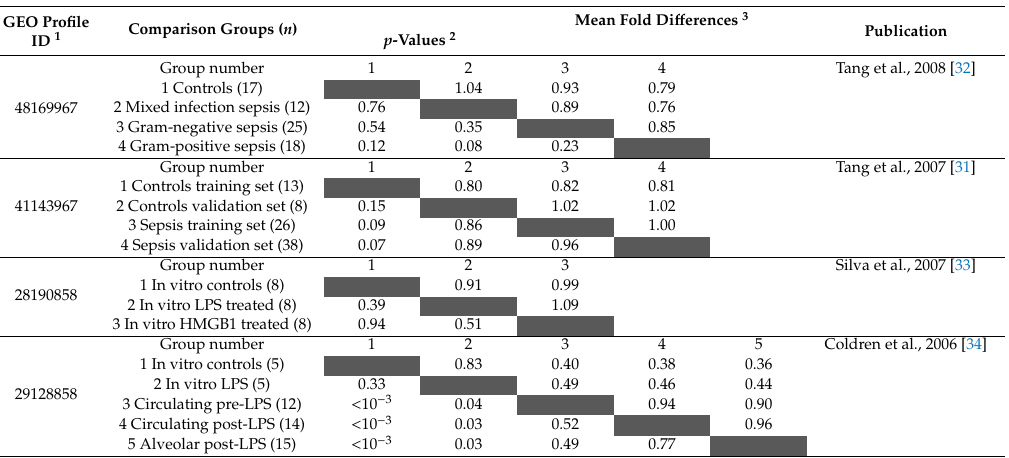
Table 3. Mean fold di ff erences in AKIRIN1 expression levels and p- values for group comparisons in neutrophil transcriptome datasets identified from GEO Profiles.